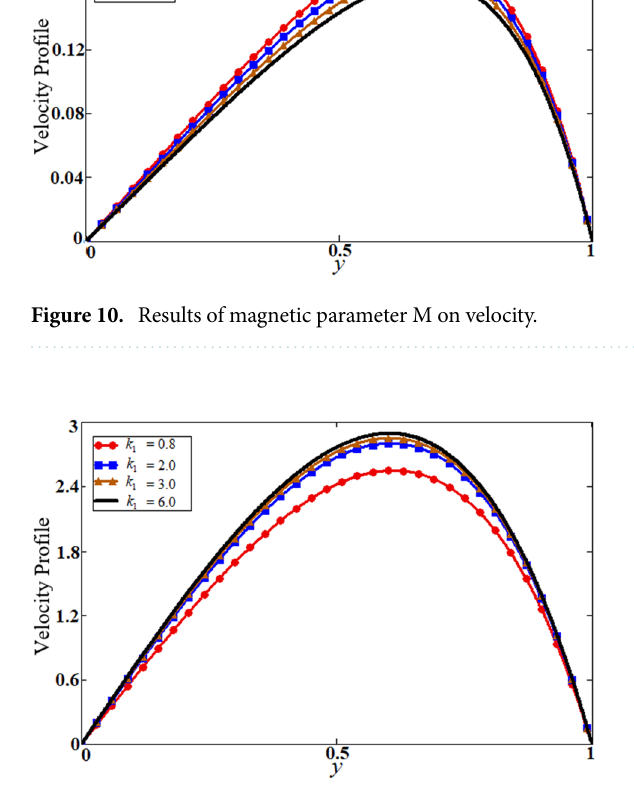
Figure 11. Results of porosity parameter k 1 on velocity.